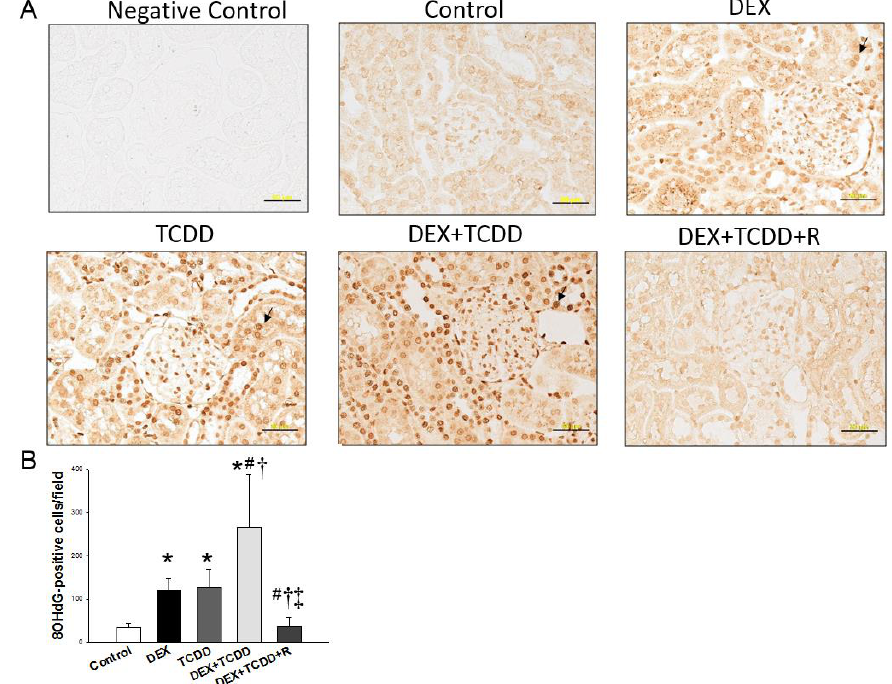
Figure 2. ( A ) Light micrographs illustrating immunostaining for 8-hydroxydeoxyguanosine (8- OHdG) in the kidneys of male offspring at 16 weeks of age. Bar = 50 μm. ( B ) Quantitative analysis of 8-OHdG-positive cells (arrowhead) per microscopic field (×400). Data were analyzed by